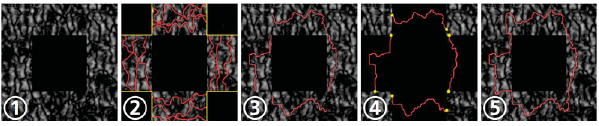
Fig. 6 Optical error image Δ I (1); possible minimal paths through the four edge-regions (2); paths with minimal cost (3); the four path segments (endpoints yellow) are connected (4); resulting cyclic boundary cut (5).